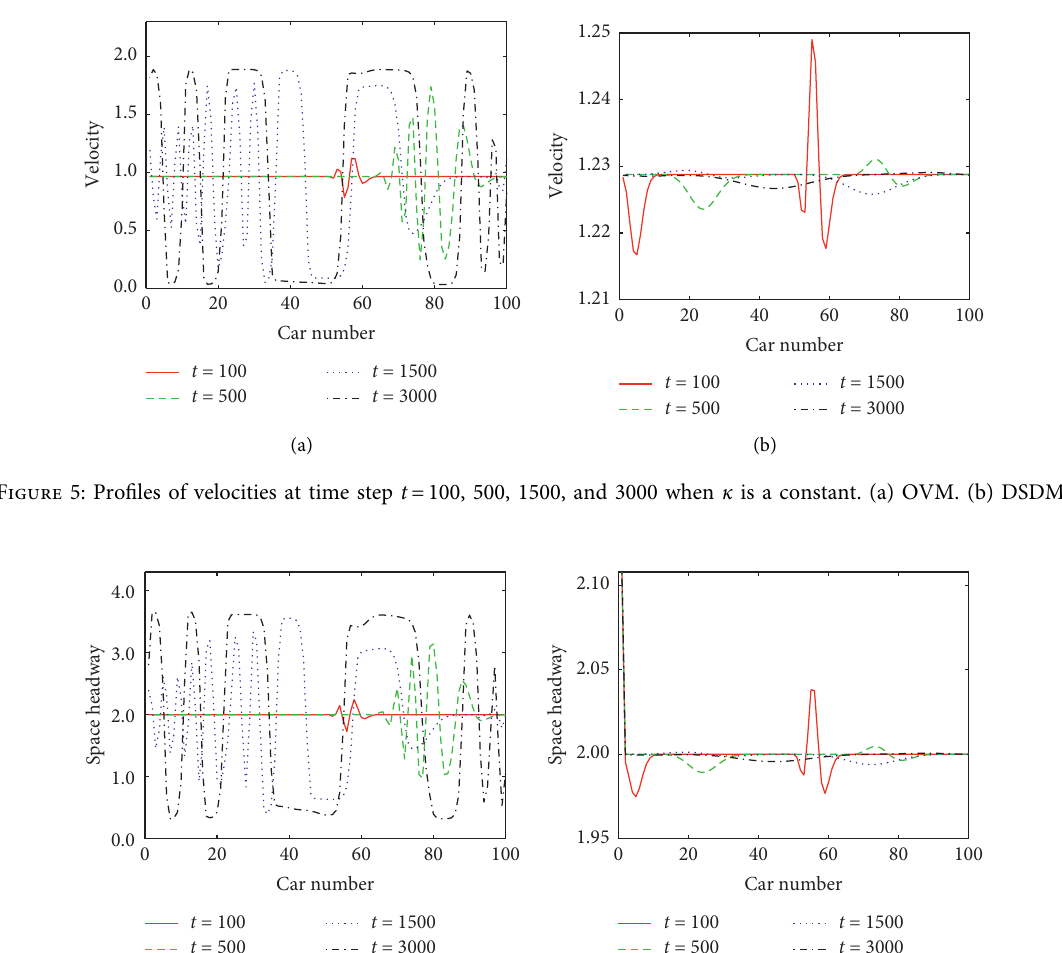
t = 100 t = 500 Figure 6: Profiles of space headway at time step t � 100, 500, 1500, and 3000 when κ is a constant. (a) OVM. (b)